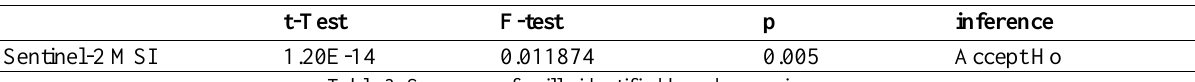
Table 3. Summary of spills identified based on regions